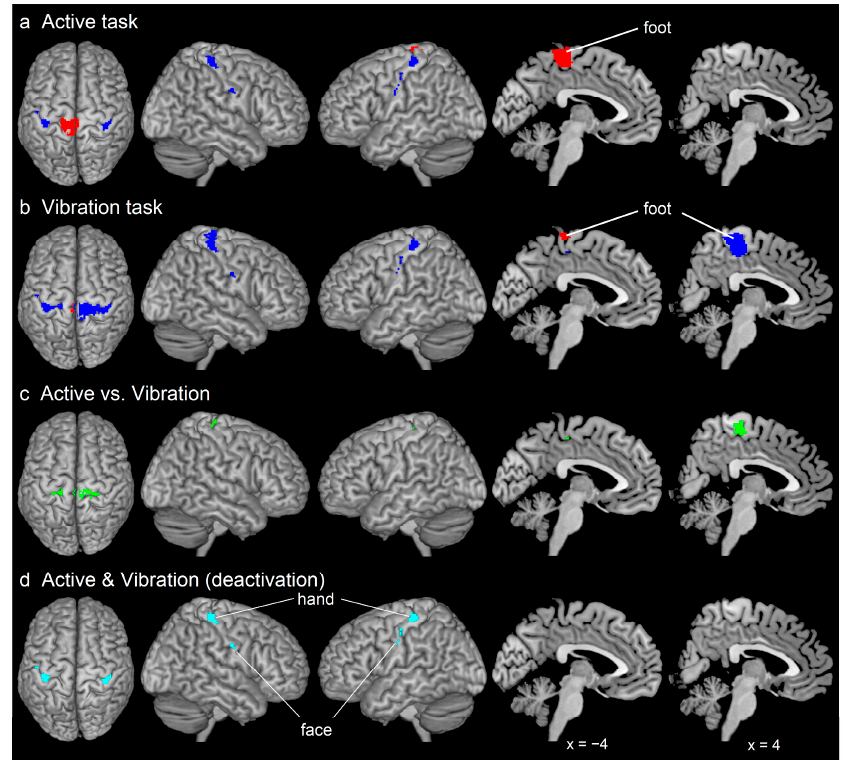
Figure 2. Results from brain image analyses. M1 regions showing significant activation (red) and deactivation (blue) during the active ( a ) and vibration tasks ( b ). ( c ): M1 regions are more deactivated during the vibration task than during the active task (green). ( d ): M1 regions consistently deactivated during both tasks (cyan). These activations and deactivations were superimposed on the MNI standard brain. Each row, from the left to the right, shows the top view, the right and left hemispheres, and the medial views of the contralateral (x = − 4) and ipsilateral hemisphere (x = 4), respectively. Abbreviations: M1, primary motor cortex; MNI, Montreal Neurological